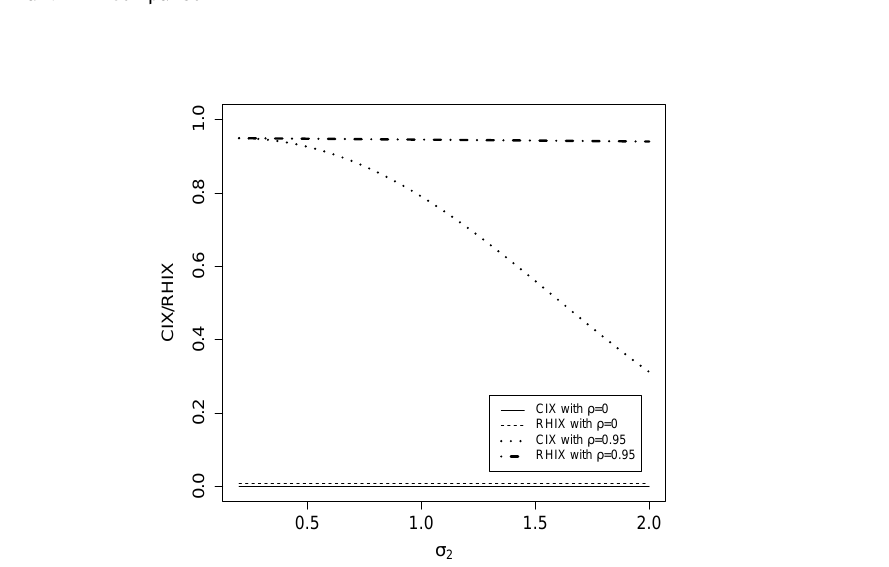
Figure 1: The HIX and RHIX Comparison